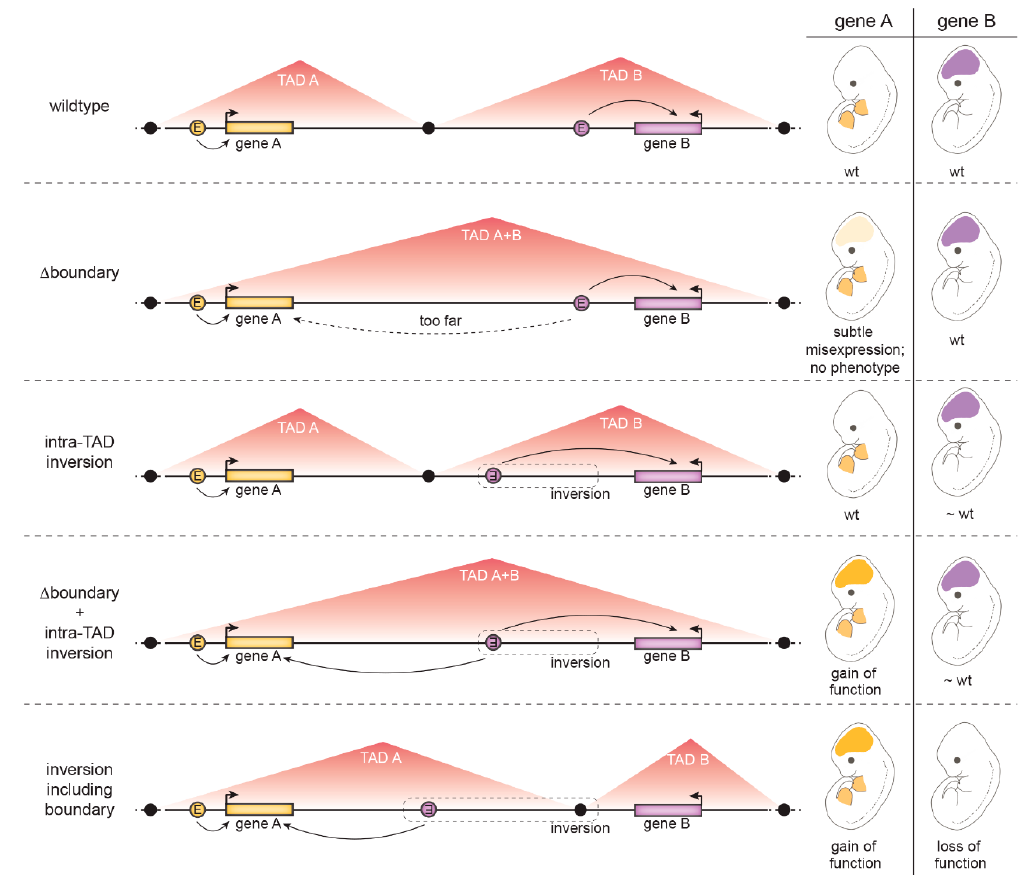
Figure 5. Re-wiring of enhancer-promoter interactions requires loss of insulation and enhancer re-direction, as illustrated at a hypothetical model locus. (Row 1) A model locus spans two TADs, each containing a developmental gene (orange or purple) and their respective enhancers that drive each gene’s respective wildtype (wt) expression pattern (in embryonic limb buds or brains in this example). (Row 2) Deletion of a TAD boundary only leads to weak activation of a formerly insulated gene by the other gene’s enhancer (in this case resulting in weak expression of gene A in the brain) because this enhancer is far away, resulting in no phenotypic outcome. Note that in addition to deleting CTCF binding sites at the TAD boundary, additional CTCF binding sites within TAD B (not shown) must be deleted to result in TAD fusion. (Row 3) An intra-TAD inversion does not a ff ect gene activation because enhancer-promoter distances are relatively insensitive to changes in linear distances within the original TAD. (Row 4) Deletion of a TAD boundary combined with an inversion that moves gene B’s enhancer closer to gene A results in strong ectopic activation of gene A in gene B’s pattern and a gain-of-function (GOF) phenotype. (Row 5) An inversion involving the TAD boundary can place enhancer B in proximity to gene A, resulting in ectopic expression of gene A in gene B’s pattern and gene A GOF. At the same time, gene B is now insulated from its enhancer and is no longer activated in its endogenous pattern, leading to gene B loss-of-function in this